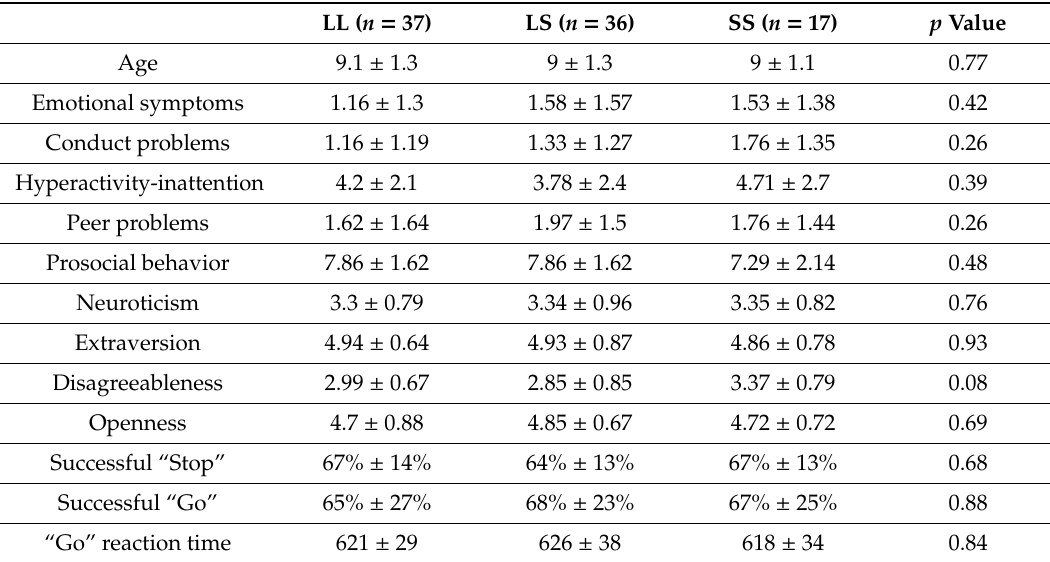
Table 1. Psychometric data for genotype groups. Values represent mean and standard deviation (mean ± SD). The p -values refer to the results from one-way